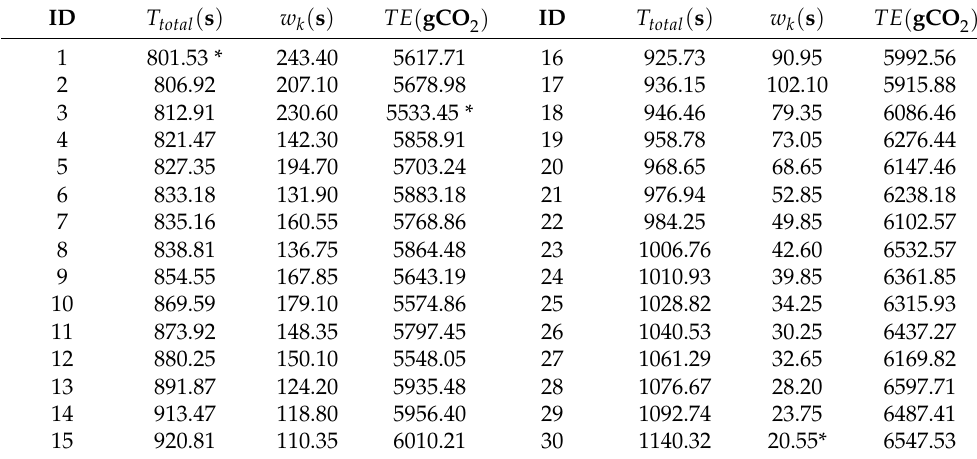
Table 5. Non-dominated